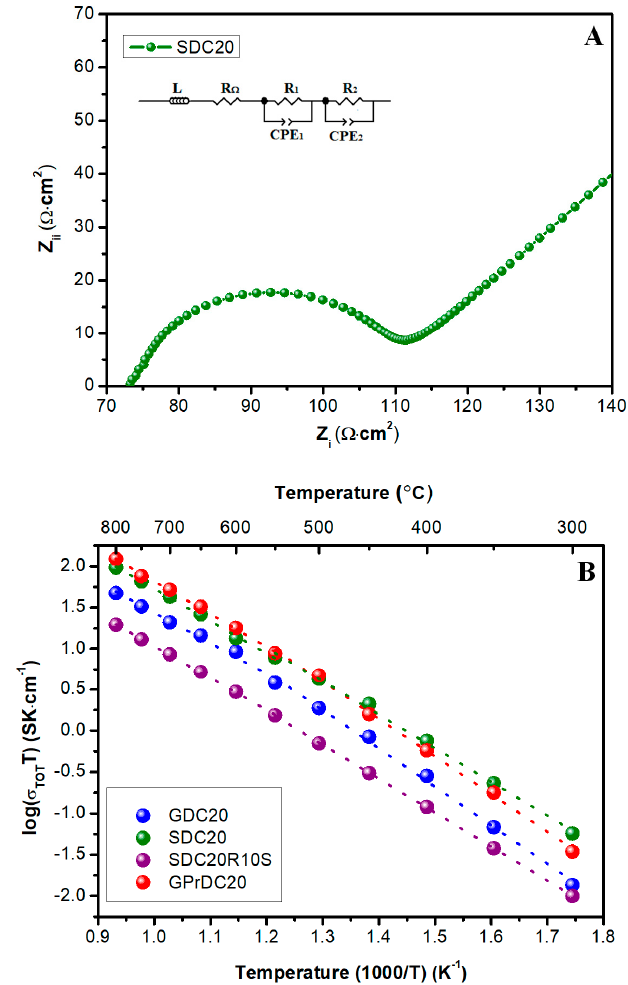
Figure 9. Nyquist plot for SDC20 at 500 ◦ C ( A ) and Arrhenius plot of total conductivity for SDC20, GPrDC20, GDC20, and SDC20R10S ( B ). Table 3. Total conductivity and activation energies for sintered